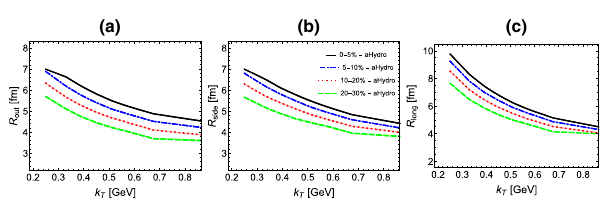
Fig. 9 HBT radii are shown as a function of k T for π + π + in the 0–5, 5–10, 10–20, and 20–30% centrality classes. The left, middle, and right columns show R out , R side , and R long , respectively. All results are for